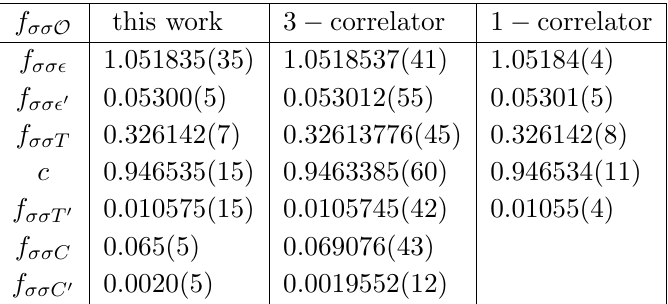
Table 2 . Comparison of d = 3 structure constants of six low-lying (cid:12)elds with earlier results of one-correlator [12] and three-correlator [13] bootstrap (the values of f (cid:27)(cid:27)T and c are related). of comparable shape for 3 (cid:21) d (cid:21) 2 : 2 and become sharper at 3 : 75 and at d = 2 : 00001